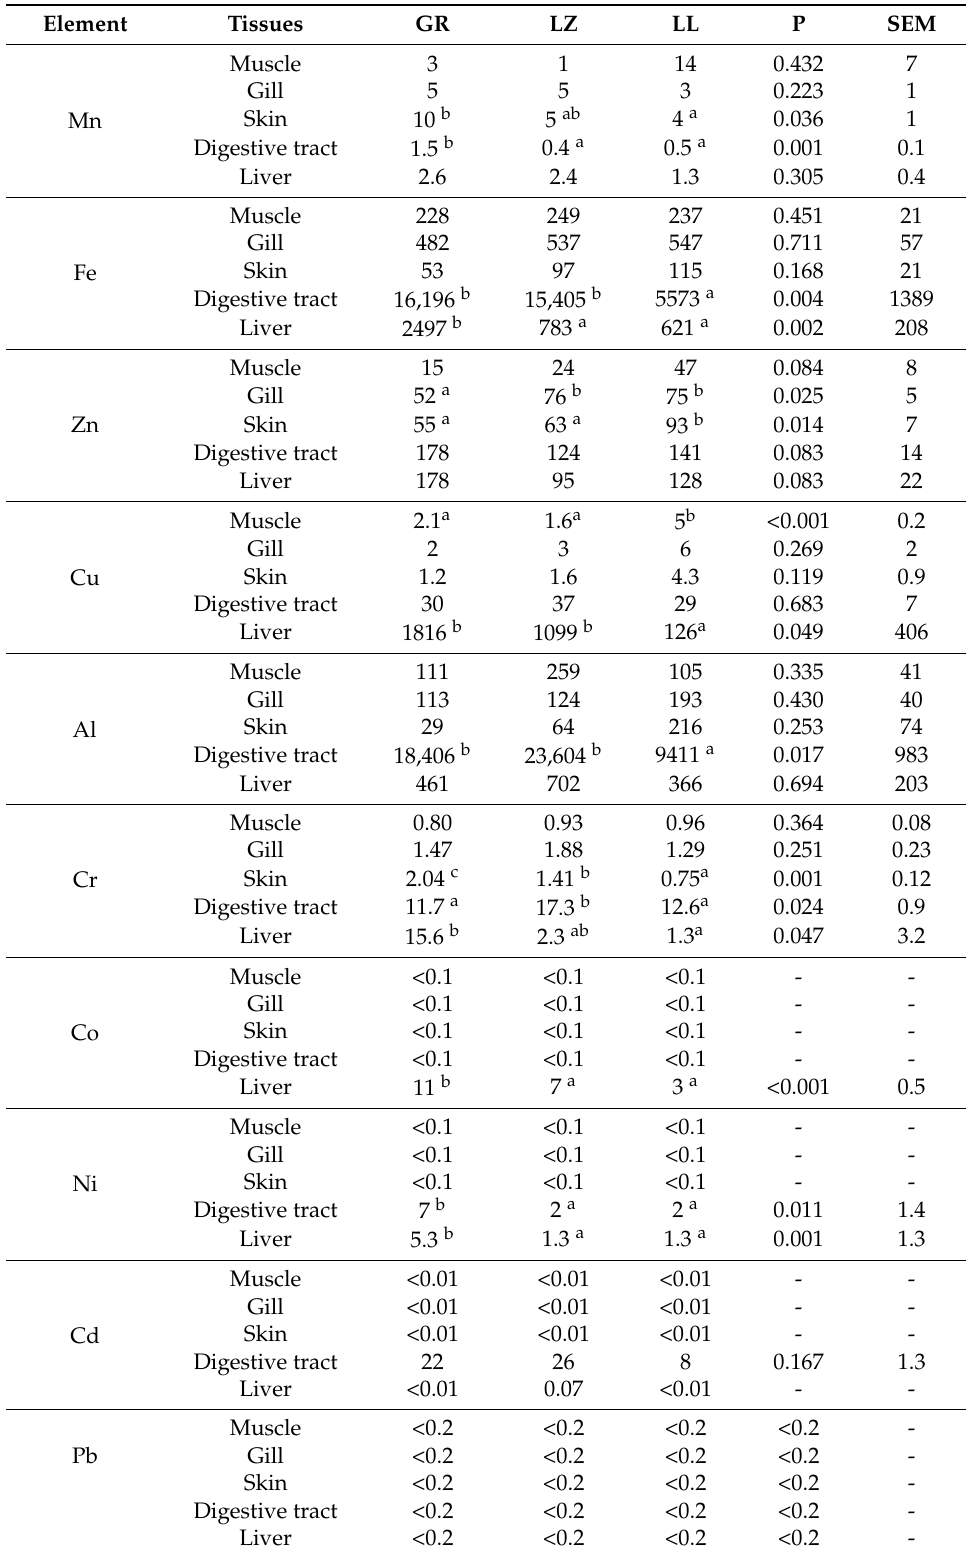
Table 4. Concentrations of trace elements in Nile tilapia tissue from three lakes in Ethiopia (mg/kg dry matter; pooled samples ( n = 3 from each